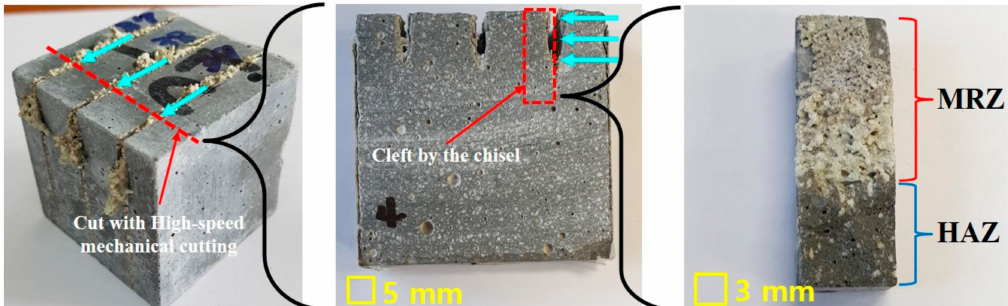
Figure 3. Fabrication process of a laser-processed specimen used scanning electron microscopy / energy dispersive X-Ray (SEM /